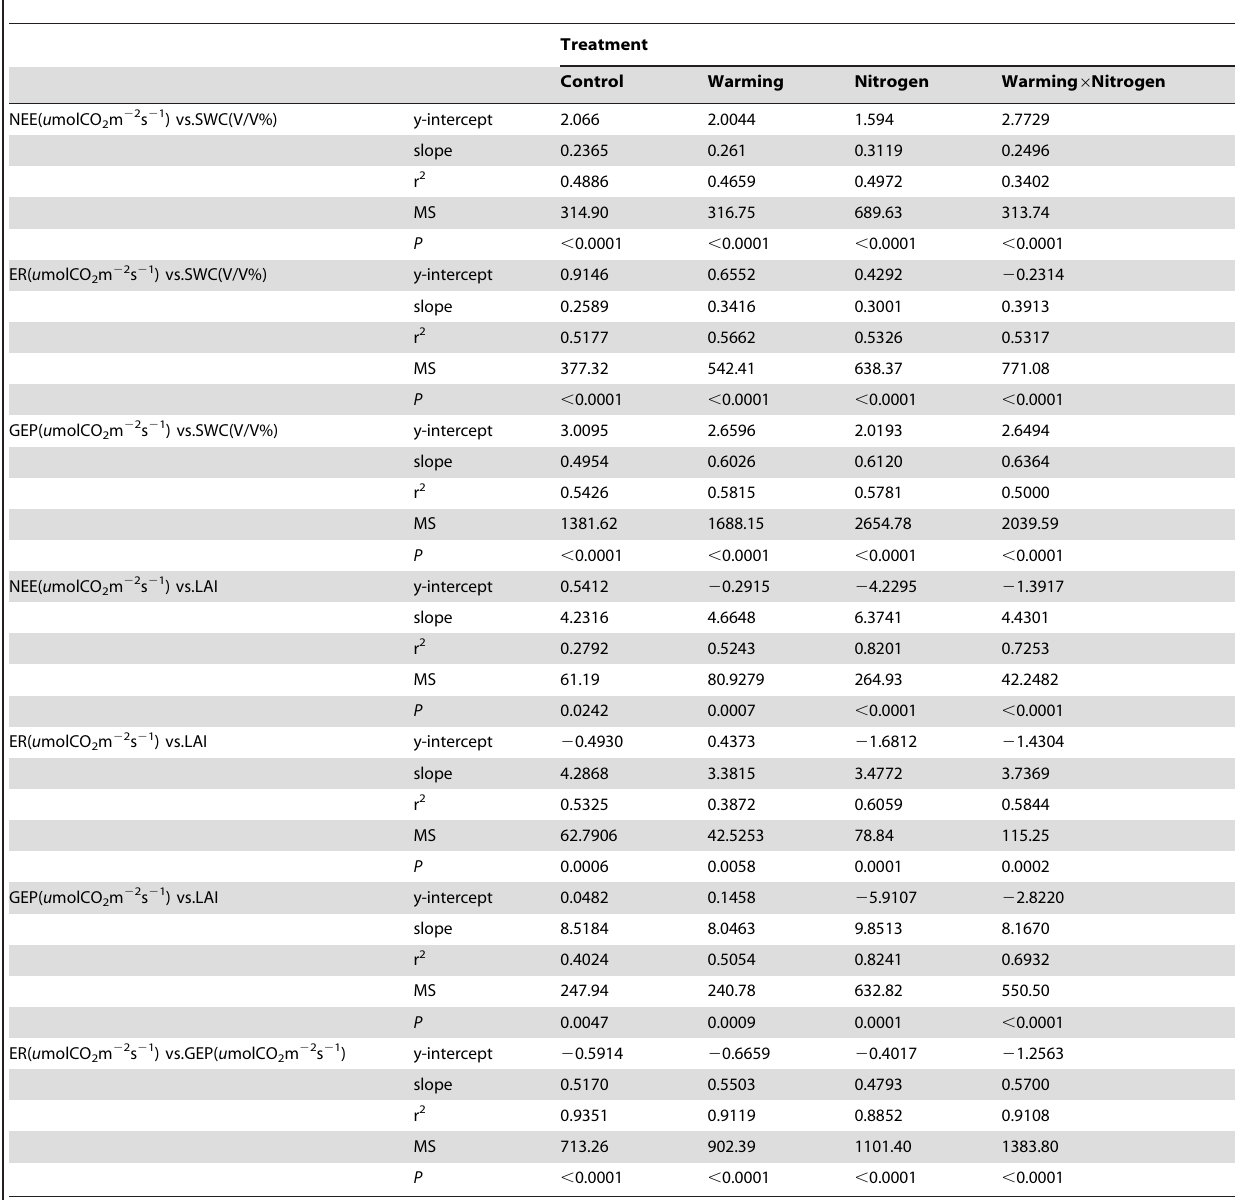
Table 4. Summary of linear regressions describing the relationship between carbon flux component and soil water content (SWC), leaf area index (LAI) and the relationship between ecosystem respiration (ER) and gross ecosystem productivity